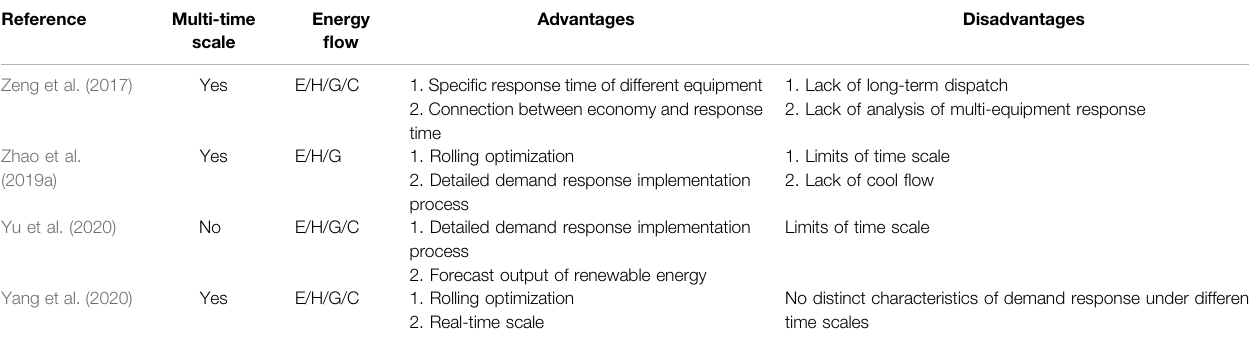
TABLE 2 | Comparison of signi fi cant works.